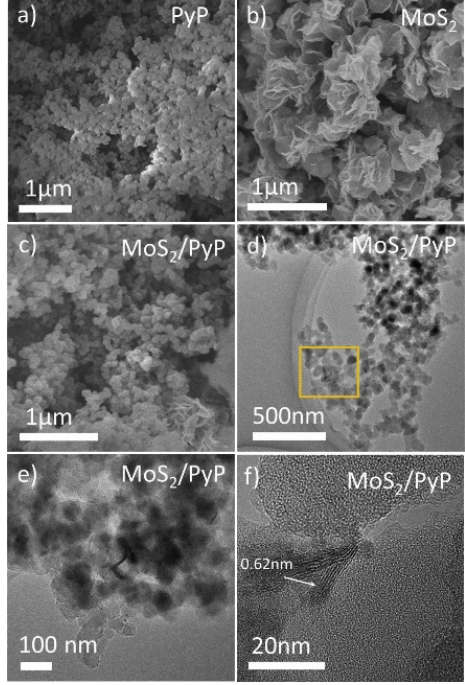
Figure 23. SEM images of ( a ) pure PyP, ( b ) MoS2 ( c ) 3 wt. % MoS2/PyP(IM) samples; ( d – f ) TEM images of 3 wt. % MoS 2 /PyP(IM) samples.